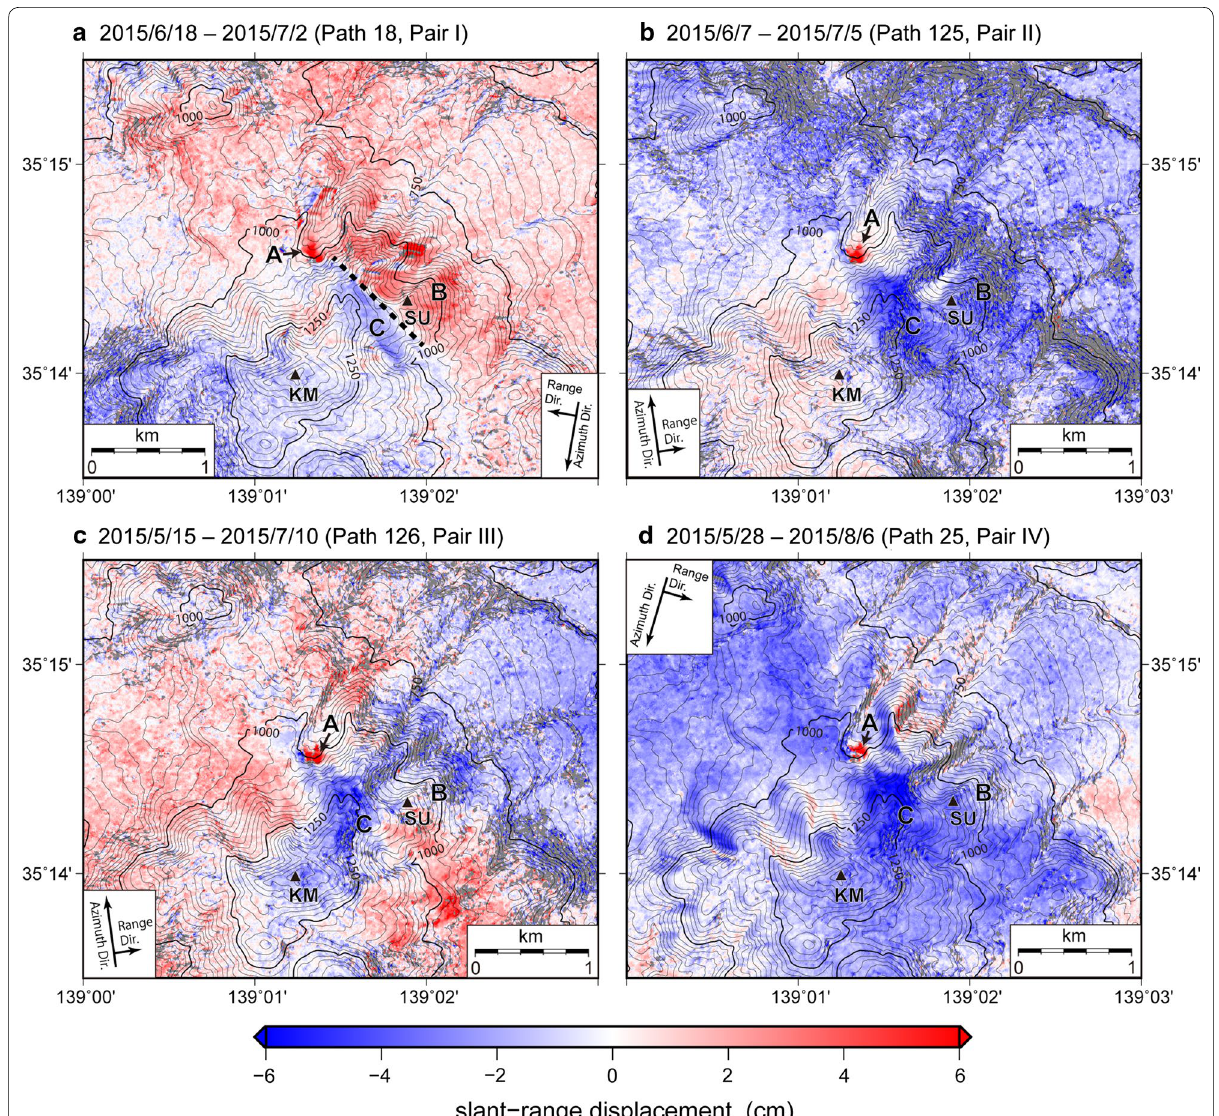
Fig. 4 Surface displacement maps from InSAR analysis of ALOS-2/PALSAR-2 images. a 2015/6/18–2015/7/2 pair (Pair I), b 2015/6/7–2015/7/5 pair (Pair II), c 2015/5/15–2015/7/10 pair (Pair III), d 2015/5/28–2015/8/6 pair (Pair IV). Positive (red colored) areas indicate displacement toward the satel- lite, and negative (blue colored) areas show displacement away from the satellite. A, B, and C show displacement areas mentioned in the text. KM and SU show the summits of Kamiyama and Sounzan, respectively. Parameters details of each pair are shown in Table